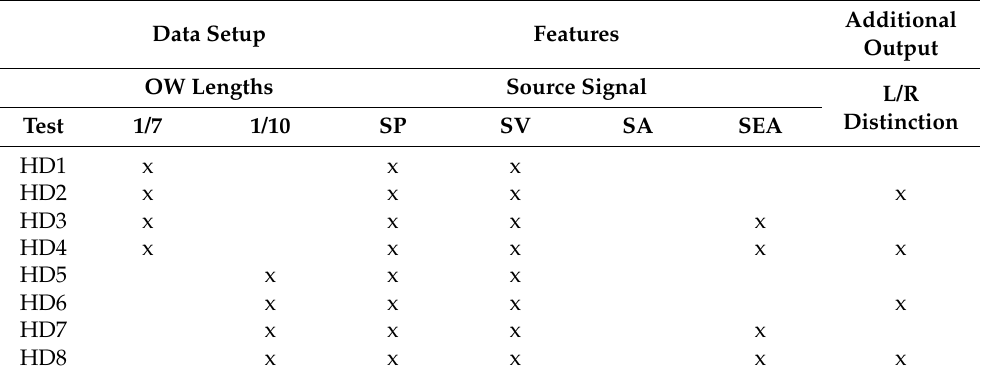
Table 2. Synthesis of the applied conditions in the tests performed for the health condition detection. For all tests, the average window approach was adopted as OW evaluation strategy. Source signals are described as sensor position (SP), sensor velocity (SV), sensor acceleration (SA), and sensor Euler angles (SEA); L/R indicates the left and right limb distinction.